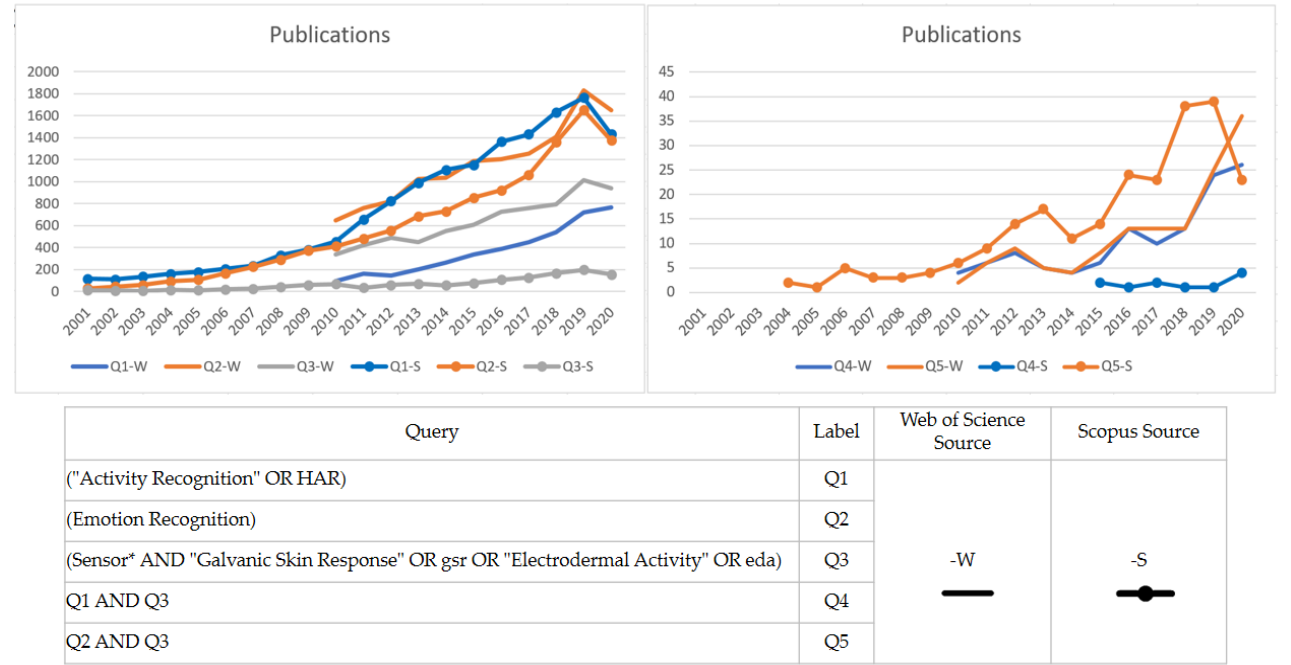
Figure 1. Trends in the scientific literature of human activity recognition (HAR), emotion recognition, and galvanic skin response/electrodermal activity (GSR/EDA) sensors. Left graph: Individual publication topics. Right graph: Publications involving the use of GSR/EDA in HAR or emotion recognition. *: a standard for searching queries in the scientific literature database, it helps to search finding words that start with the same letters.